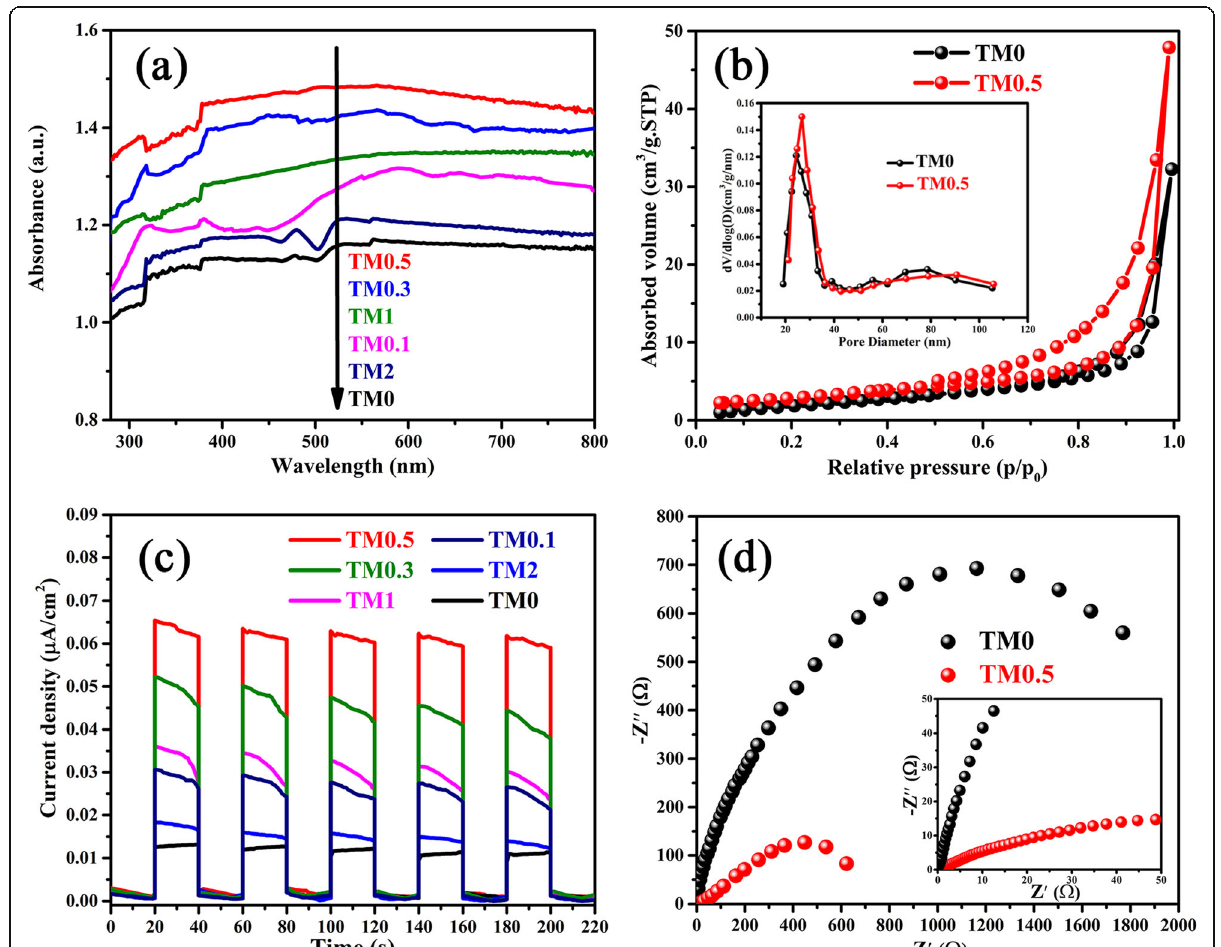
Fig. 3 a UV-vis diffuse reflectance spectra (DRS) of as-synthesized TM0, TM0.1, TM0.3, TM0.5, TM1, and TM2 samples. b N 2 adsorption-desorption isotherms for the as-prepared TM0 and TM0.5 powders. c Photocurrent response of TM0, TM0.1, TM0.3, TM0.5, TM1, and TM2. d Electrochemical impedance spectra of TM0 and TM0.5